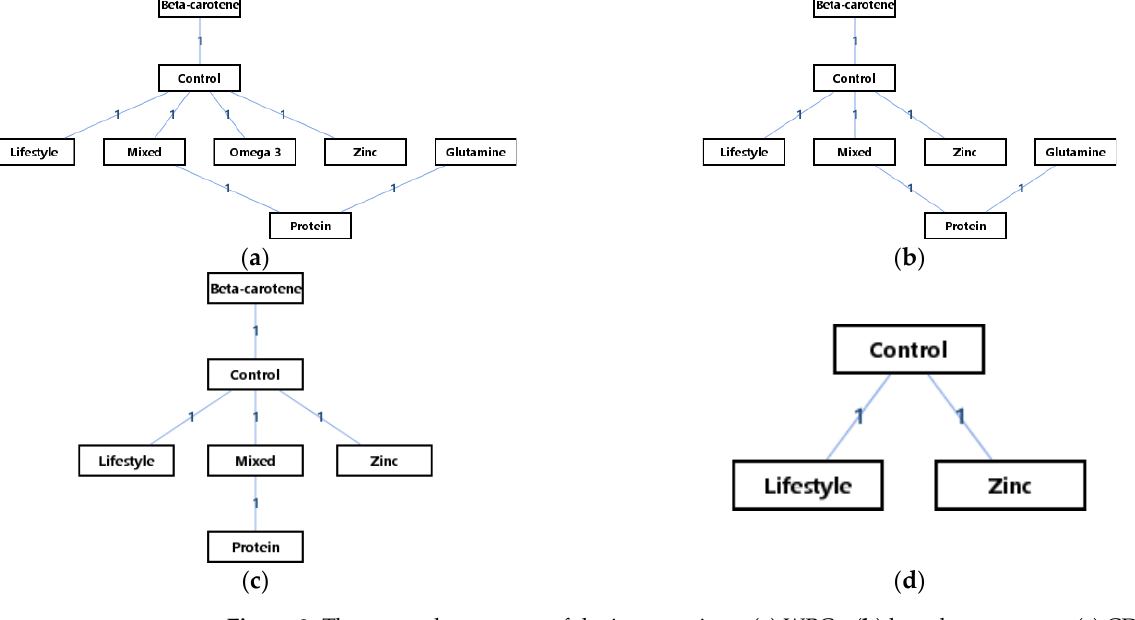
Figure 2. The network geometry of the interventions: ( a ) WBCs; ( b ) lymphocyte count; ( c ) CD4/CD8; ( d ) neutrophil